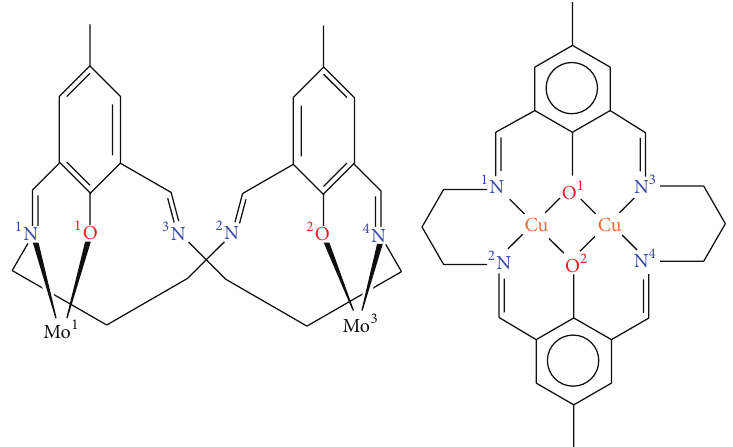
Scheme 1: Modes of coordination of the ligand tidf 2− . Numbering refers to Figures 2 and